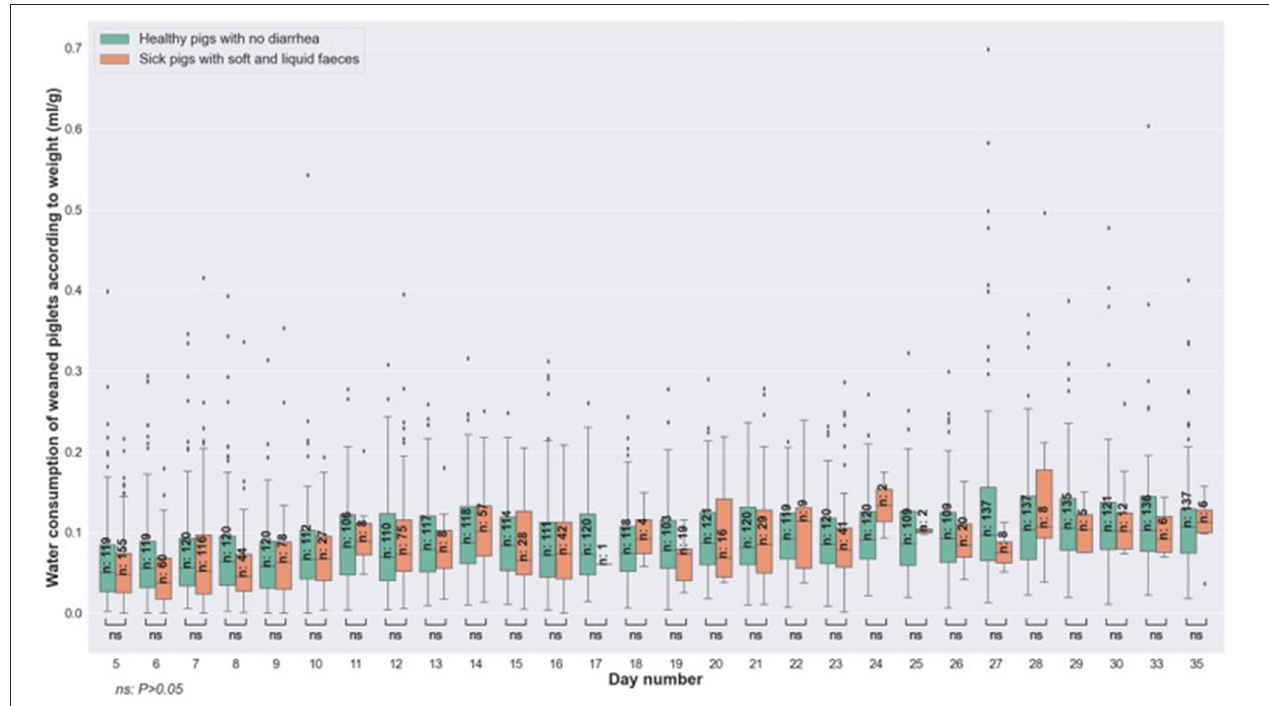
FIGURE 3 | Comparison of water consumption related to weight, between healthy pigs (no diarrhea) vs. sick animals (with soft and liquid diarrhea) at the same age and on the day of onset of